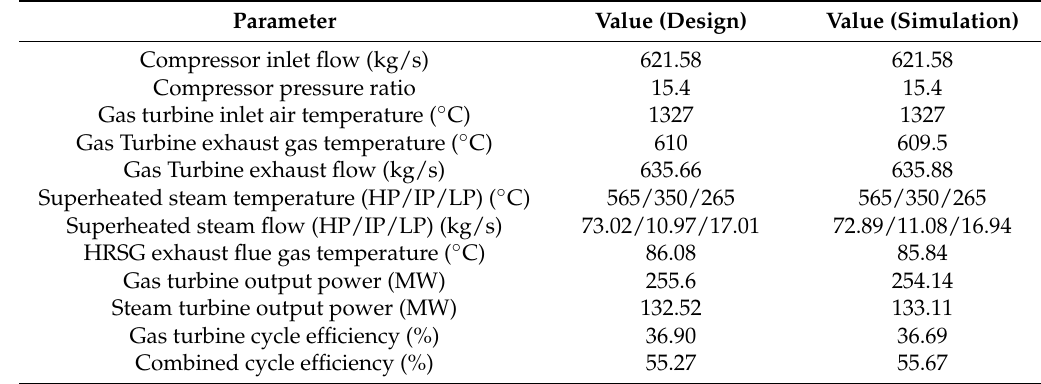
Table 4. Comparison of thermodynamic calculation results of the GTCC